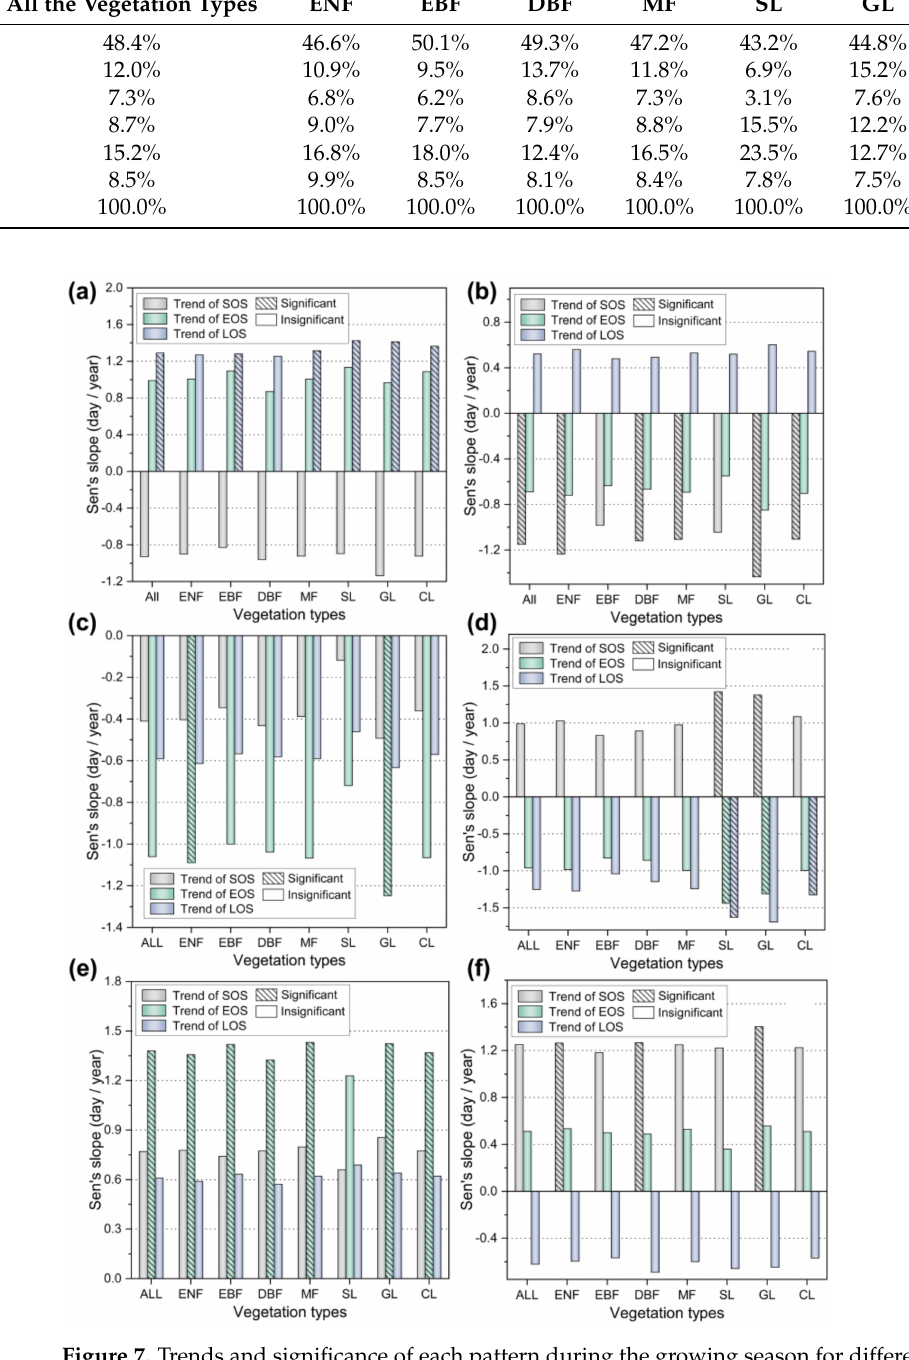
Table 4. The percentage of phenology metrics datasets consisting of each pixel showing different change patterns in the growing seasons for all the vegetation types. Change patterns refer to the trend groupings in Table 2. Change Patterns